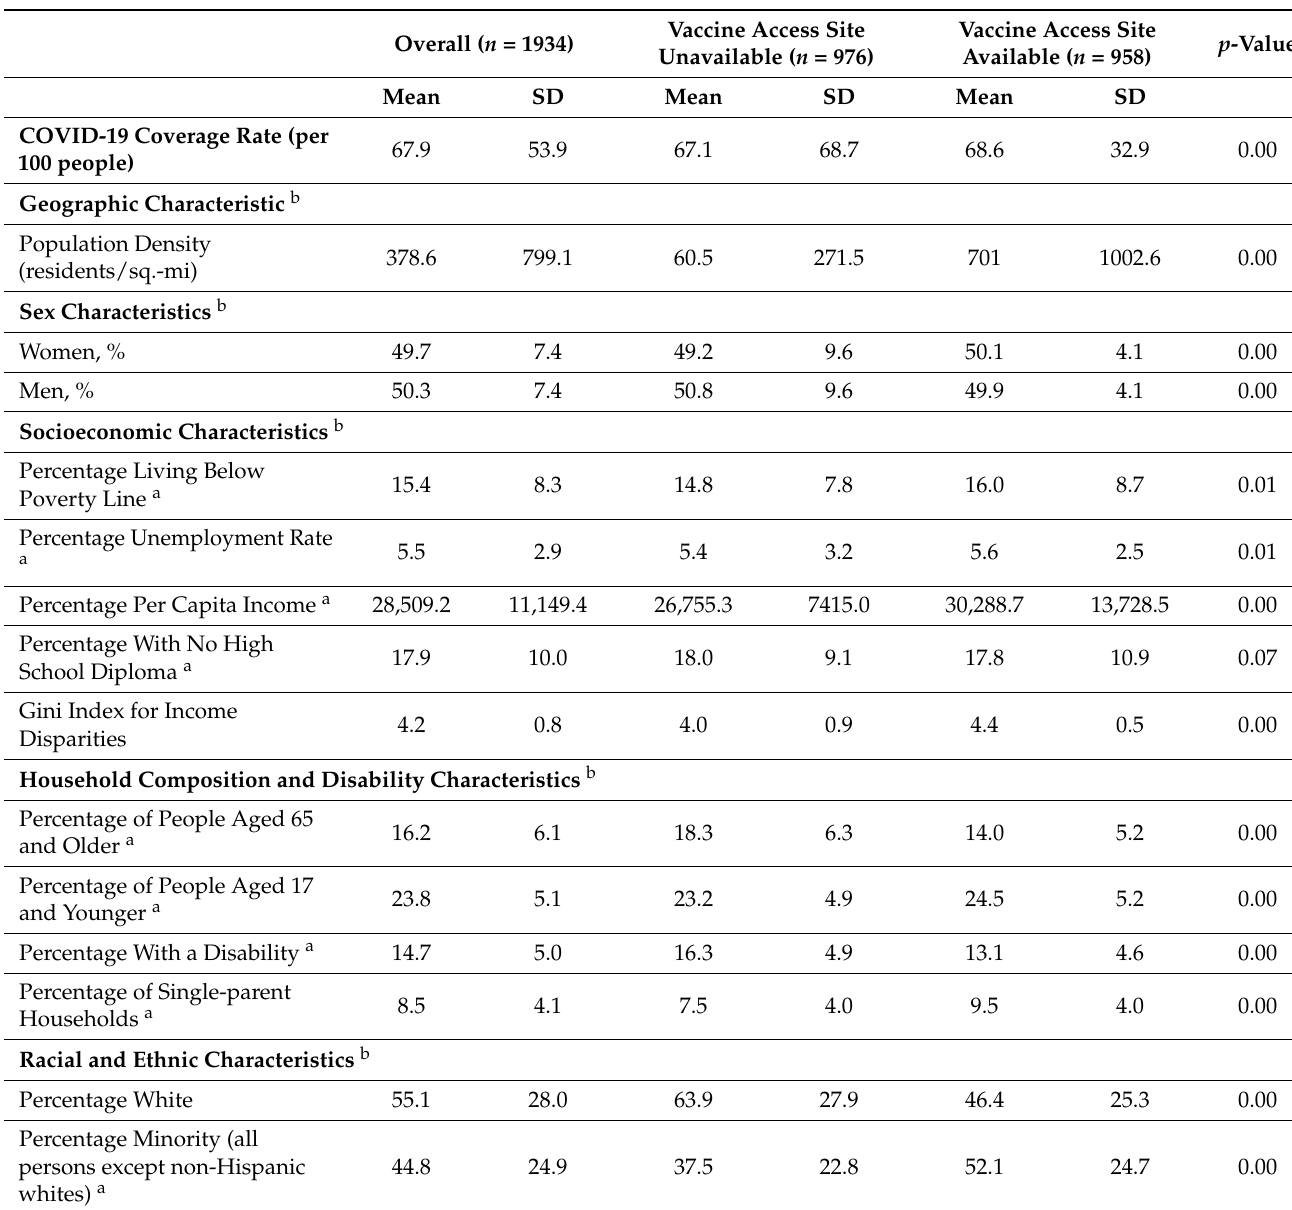
Table 1. Characteristics of ZIP codes included in the study by vaccine access site